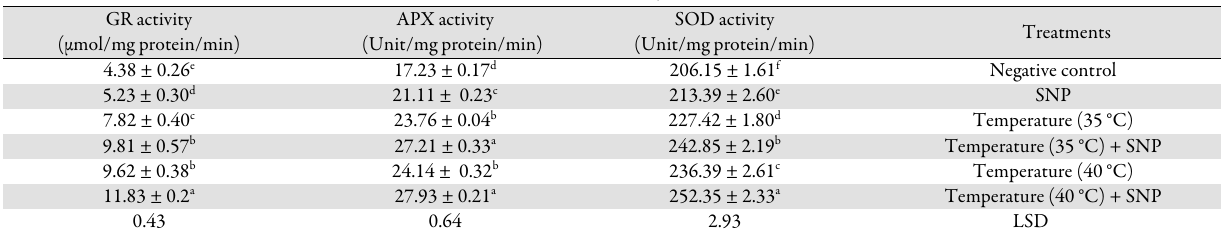
Means in the same column with the same letter were not significantly at P<